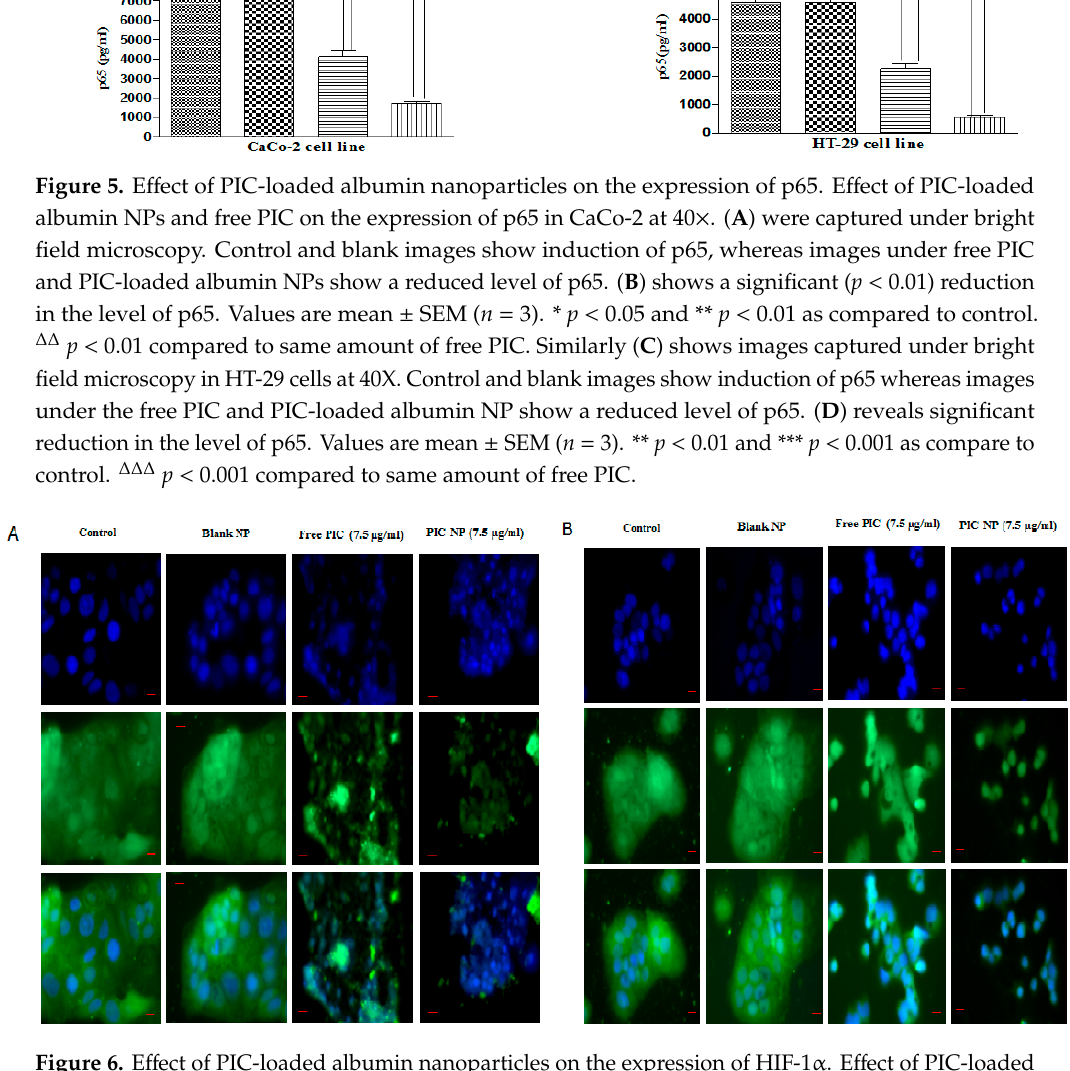
Figure 6. E ff ect of PIC-loaded albumin nanoparticles on the expression of HIF-1 α . E ff ect of PIC-loaded albumin NPs and free PIC on the expression HIF-1 α in CaCo-2 ( A ) and HT-29 ( B ) at 40 × . The above images shows induction of HIF-1 α in control and blank transfected group, whereas images under free PIC and PIC-loaded albumin NPs show a reduced level of HIF-1 α .